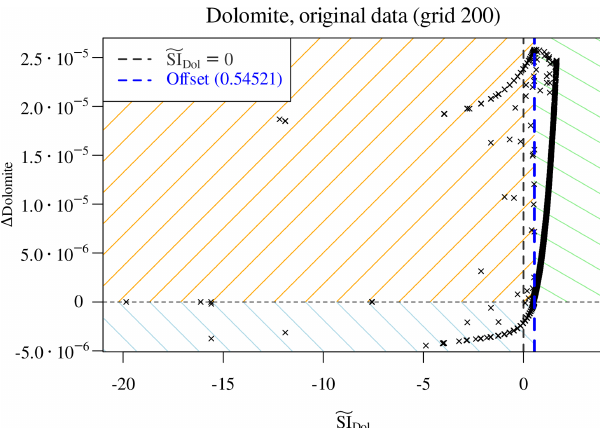
Figure 6. Scatter plot of (cid:49) dolomite vs. estimated (cid:101) SI Dol . The theo- retical (cid:101) SI Dol = 0 does not discriminate the initially undersaturated from the oversaturated samples (dashed vertical black line) and must be corrected with an apparent offset (blue dashed line). The plot identifies three distinct regions in parameter space: initially su- persaturated and precipitating dolomite (top right, green shading), initially undersaturated and dissolving (bottom left, blue shading), and points at which dolomite is initially undersaturated but ends up precipitating (top left, orange shading).